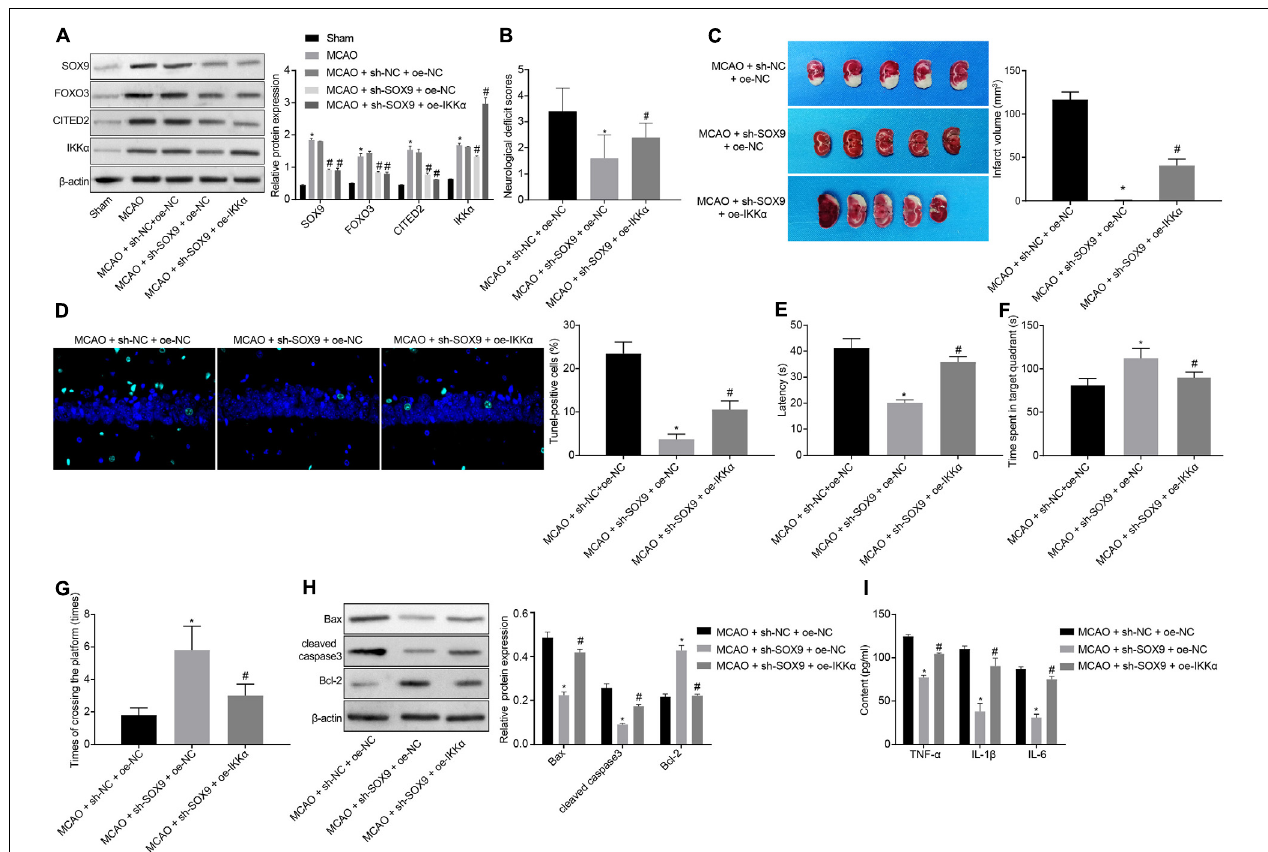
FIGURE 6 | SOX9 facilitates IBI in rats though upregulation of the FOXO3/CITED2/IKK axis. (A) Western blot analysis for measurement of expression of SOX9, FOXO3, CITED2, and IKK α normalized to β -actin in brain tissues of rats. (B) mNSS of rats. (C) Results of TTC staining for typical cerebral infarction foci in rats. (D) Examination of neuronal cell apoptosis in rats by TUNEL (400 × ). (E) The latency time of rats assessed by MWM. (F) Ratio of time spent by rats staying in the quadrant of the platform. (G) The number of times rat passed through the target platform quadrant. (H) Expression of apoptosis-related proteins (cleaved caspase 3, Bax, Bcl-2, and caspase 3 expression) normalized to β -actin in rat brain tissues determined by western blot analysis. (I) Expression of inflammatory cytokines (TNF- α , IL-1 β , and IL-6) in brain tissues of rats measured by ELISA. In panel (A) , * p < 0.05 vs. sham-operated rats; # p < 0.05 vs. MCAO-operated rats treated with sh-NC; In panels (B–I) , * p < 0.05 vs. MCAO-operated rats treated with sh-NC and oe-NC; # p < 0.05 vs. MCAO-operated rats treated with sh-SOX9 and oe-NC. Measurement data were expressed as mean ± standard deviation. Comparisons among multiple groups were conducted by one-way ANOVA with Tukey’s post hoc test. The experiment was repeated three times